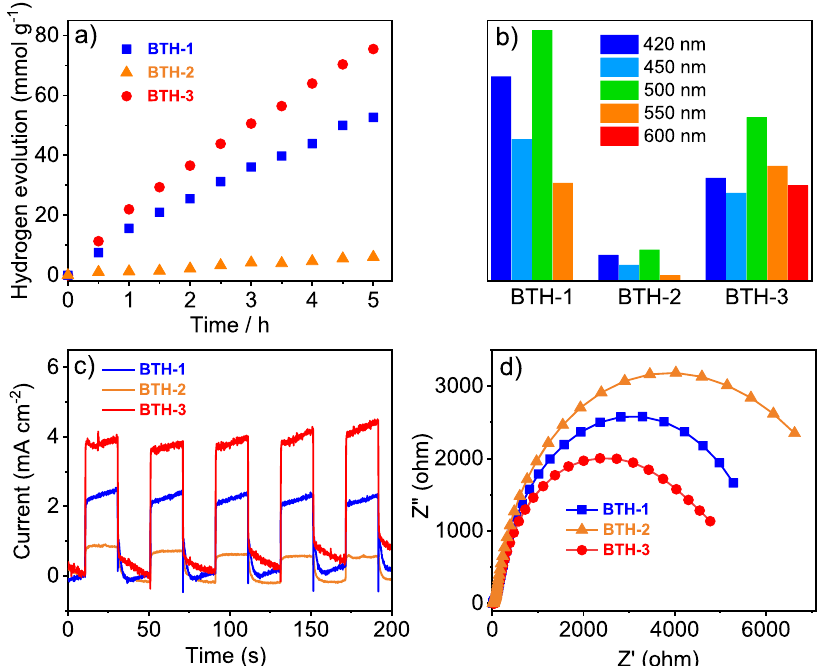
Fig. 4 Photocatalytic H 2 evolution. a Time course of photocatalytic hydrogen evolution under visible light irradiation (>420 nm) for BTH-1, 2, 3 . b AQY of BTH-1, 2, 3 under different monochromatic light irradiation. c Periodic on/off photocurrent output of BTH-1, 2, 3 casted on FTO glass. d Electrochemical impedance spectroscopy Nyquist plots of BTH-1, 2, 3